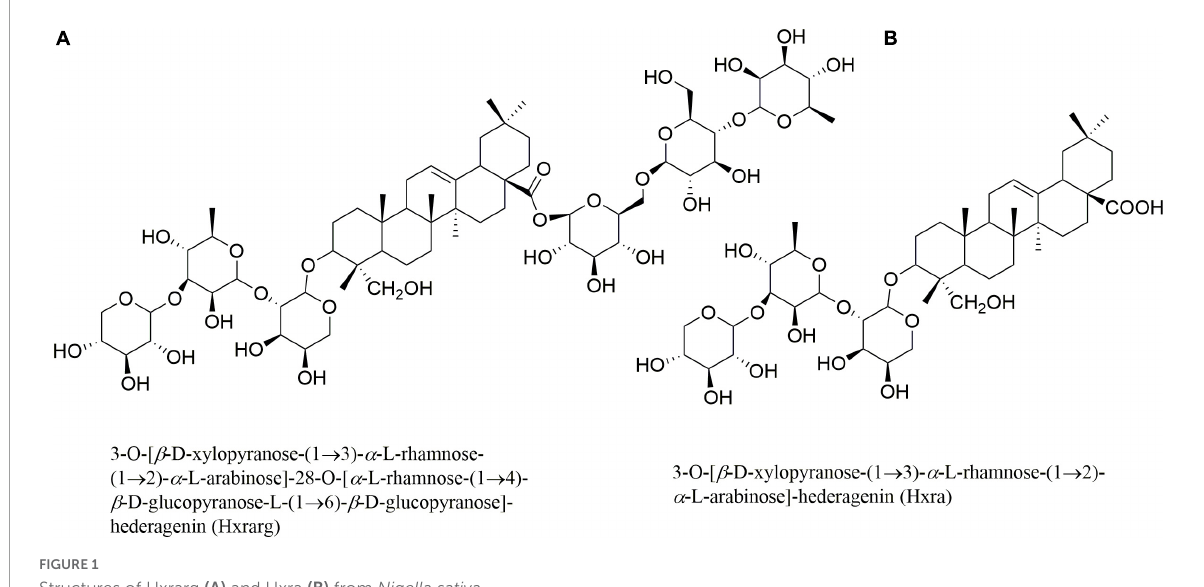
FIGURE1 Structures of Hxrarg (A) and Hxra (B) from Nigella sativa